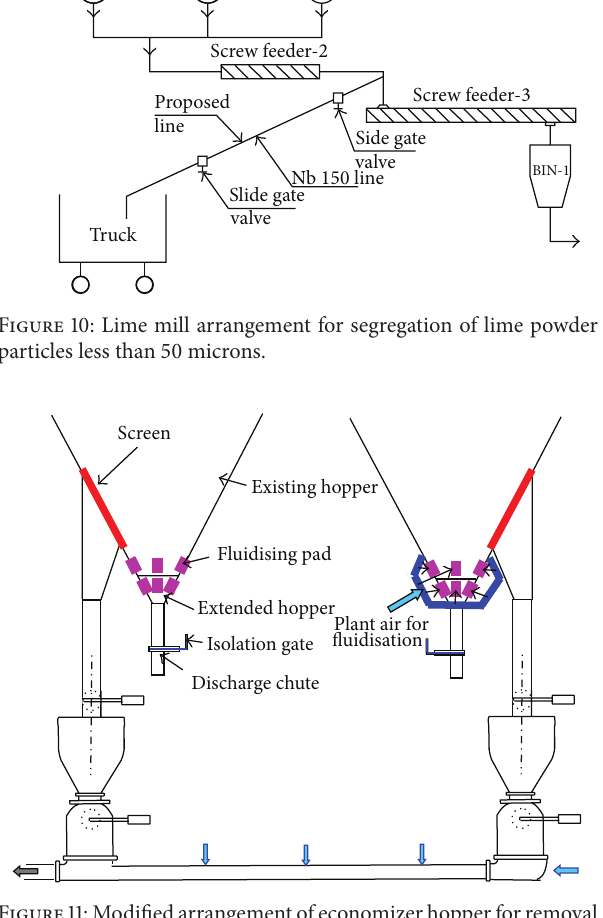
Figure 11: Modified arrangement of economizer hopper for removal of bigger